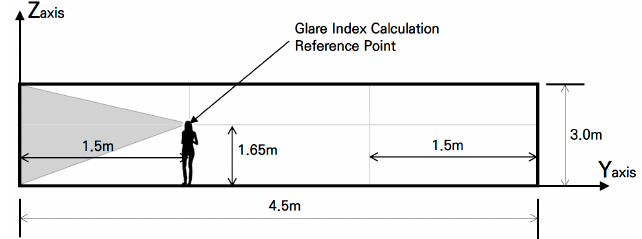
Figure 7. Reference point for DGI analysis of the analysis model.